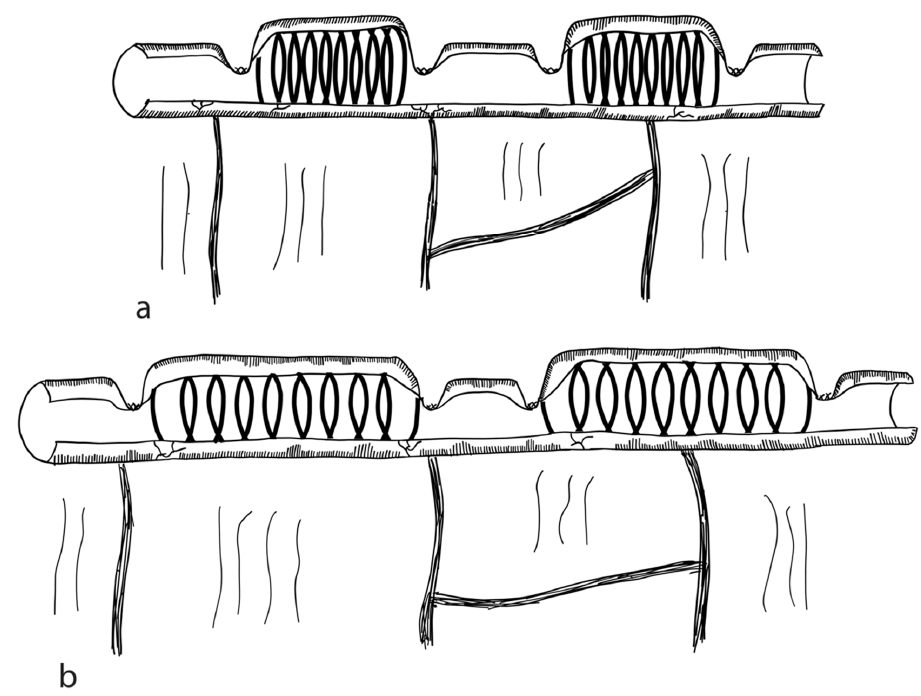
Figure 10. ( a ) Small intestine with introduced springs secured by plications. ( b ) Small intestine with elongated springs. Dubrovsky et al.